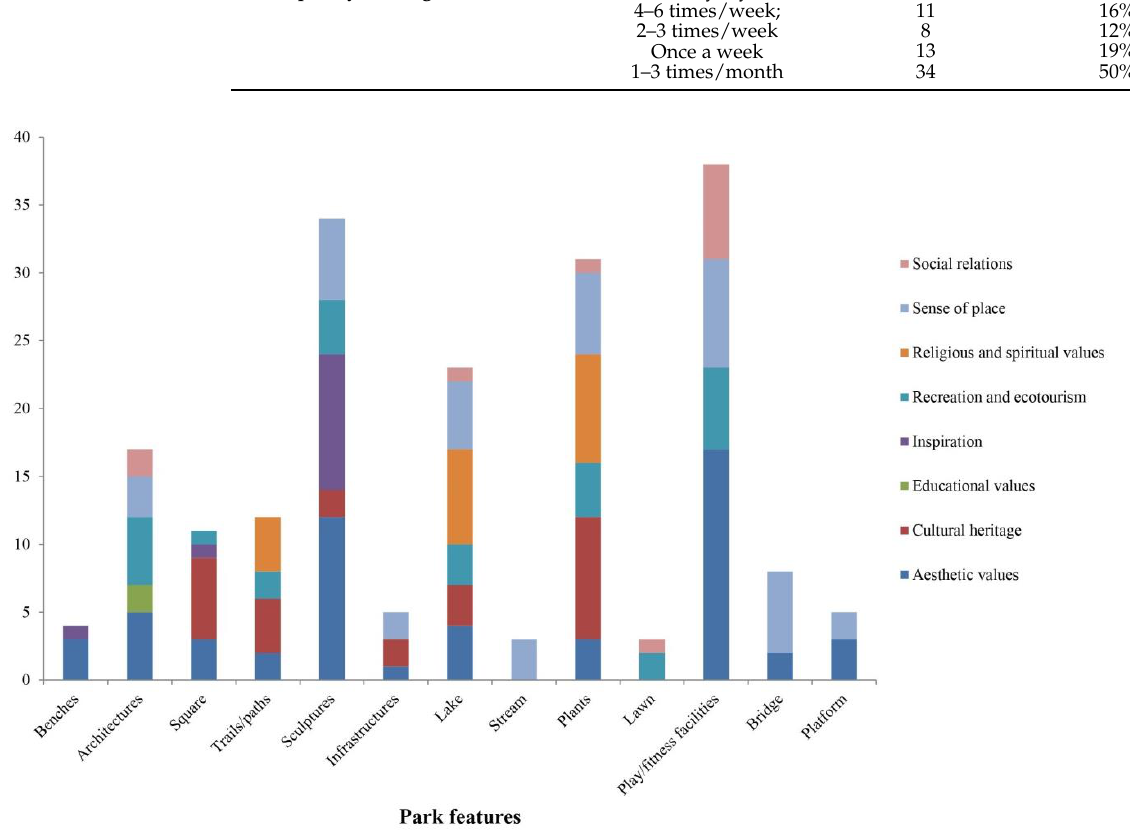
Figure A1. Counts of park features mentioned by interviewees that have negative effects on each service.